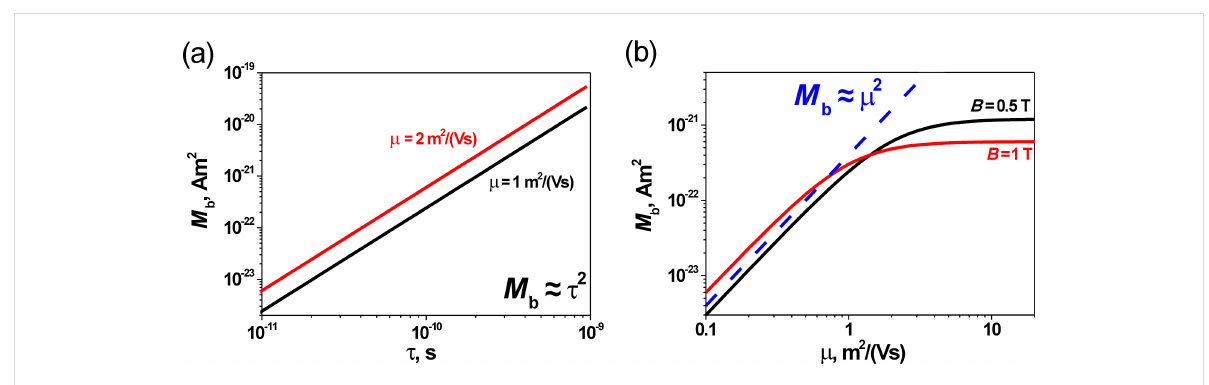
Figure 3: Theoretical dependence of the PME magnetic flux: (a) vs the carrier lifetime for different values of carrier mobility ( B = 0.5 T; R b = 1 mm; I V0 = 10 21 photons/(m 2 s)); (b) vs the carrier mobility at varying values of magnetic field ( τ = 10 − 10 s, R b = 1 mm, and I V0 = 10 21 photons/(m 2